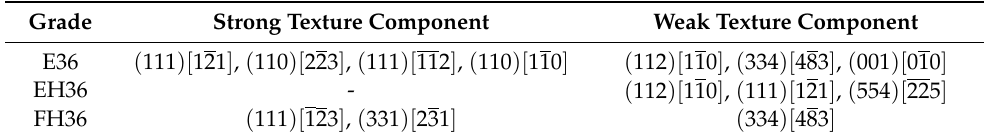
Table 4. Main texture components in the three grades of steel plate.